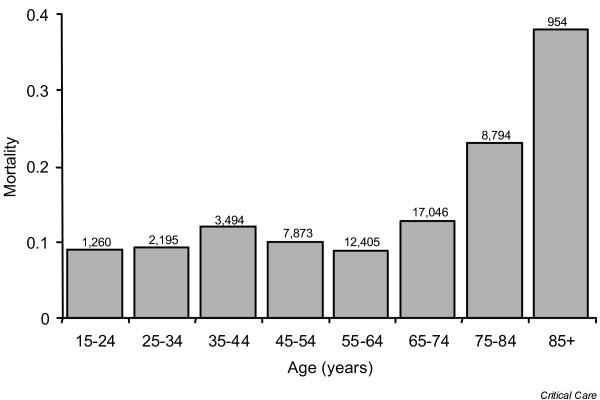
In-hospital mortality by age group in the Dutch National Intensive Care Evaluation database (n = 54021) [18]. Numbers indicate patients per age group.